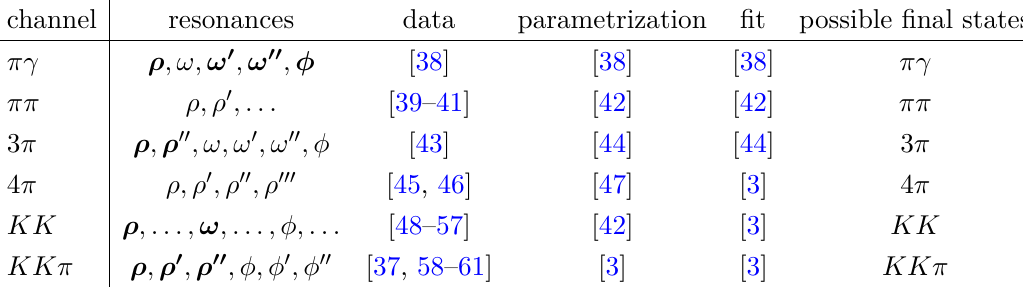
Table 2 . Dominant hadronic processes included in this work as well as in the DarkCast code [13]. We specify the resonances included in the first but not in the latter in boldface a and denote channels where a tower of vector meson resonances was considered with ‘ . . . ’ . As possible final states we consider low-energy pseudoscalar mesons, π and K , as well as photons. a DarkCast takes into account higher resonances in an approximate way by adding a non-resonant background function to mimic the shape of the data, whereas we stick to the VMD assumption and calculate each channel by considering resonance